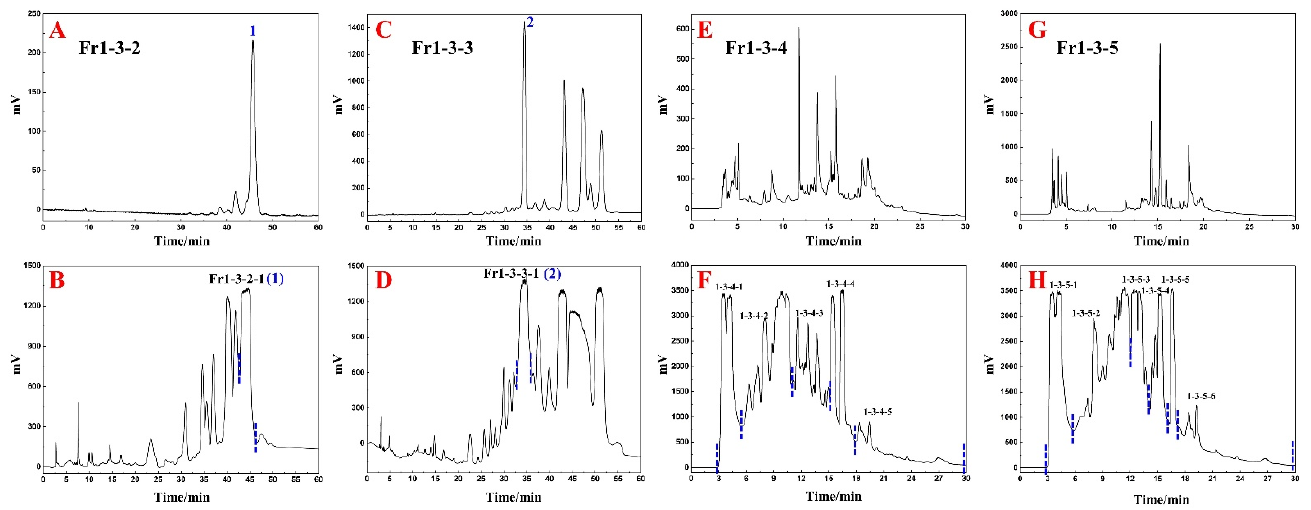
Figure 4. Fr1-3-2 and Fr1-3-3 in the analytical chromatograms ( A , C ) and preparative chromatograms ( B , D ) of the ReproSil-Pur C18 AQ column, respectively. Fr1-3-4 and Fr1-3-5 in the analytical chromatograms ( E , G ) and preparative chromatograms ( F , H ) of the Click XIon column, respectively.